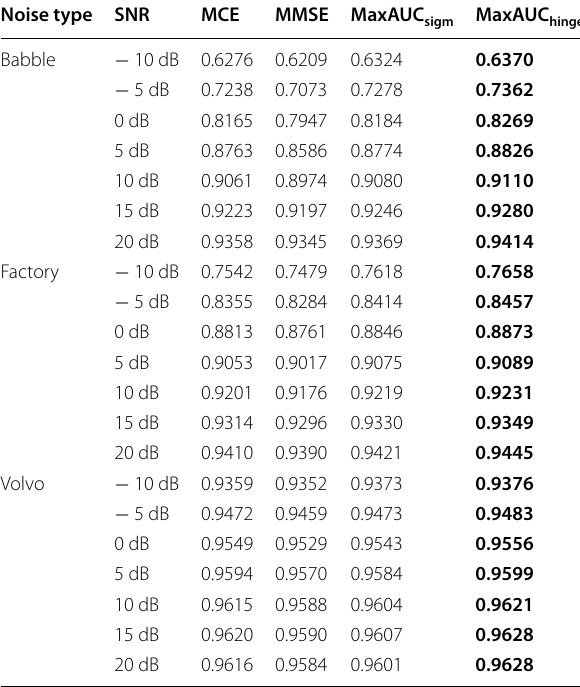
Table 5 AUC results of the comparison VADs with the BLSTM model and MRCG acoustic feature on the Chinese Noisy‑ THCHS‑30 test dataset